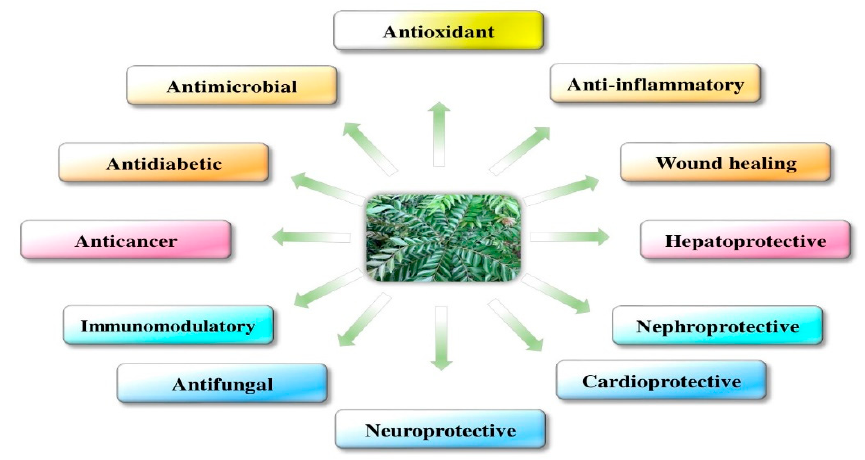
Figure 1. Pharmacological activities of Murraya koenigii.